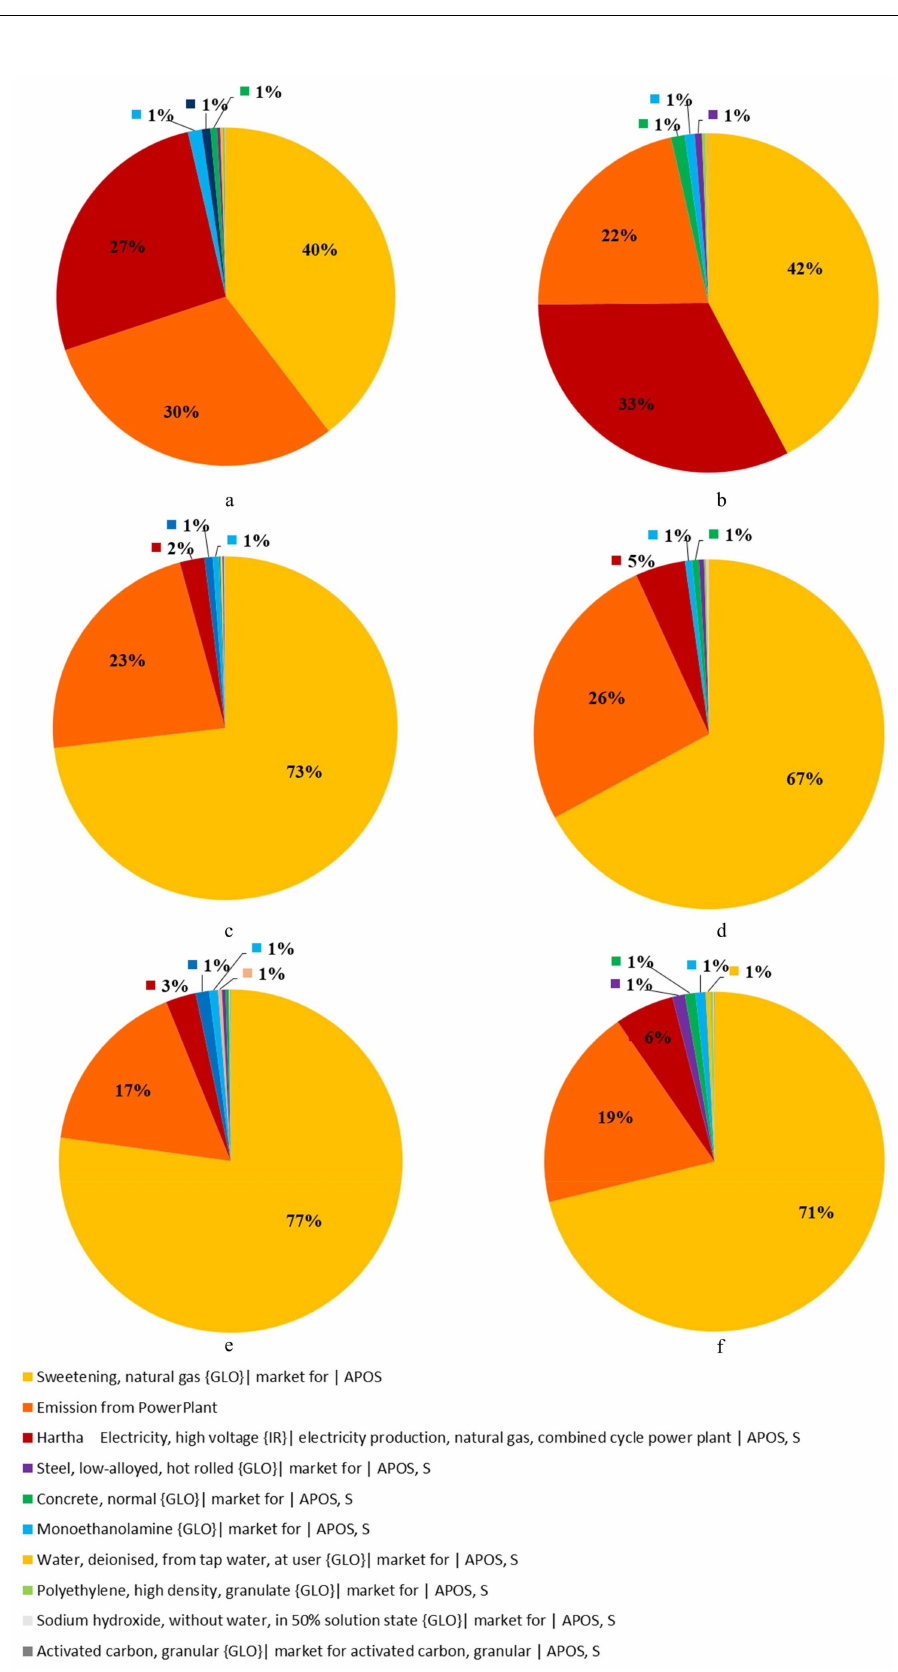
Figure 9. Process contribution ( a , c , e ) is the share of GWP, AP, PMFP for the grassroots scenario, respectively, ( b , d , f ) is the share of GWP, AP, PMFP for the retrofit scenario,